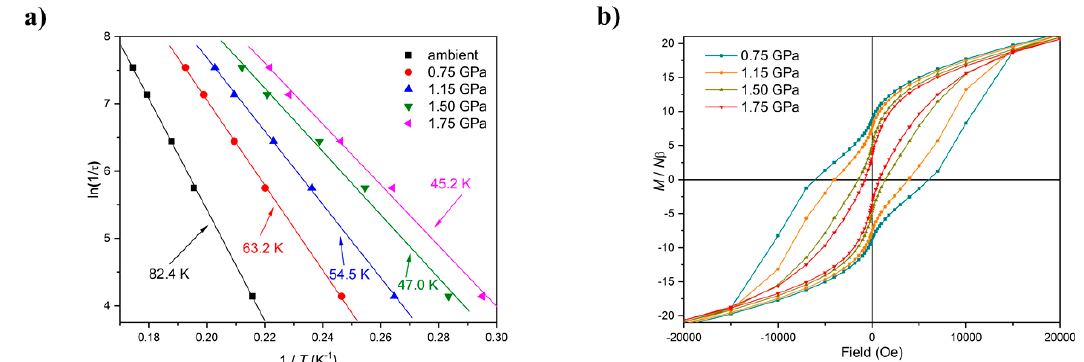
Figure 4. ( a ) Arrhenius plots based on out-of-phase ac susceptibility measurements of 1 at different pressures. ( b ) Hysteresis loops for 1 recorded at the indicated pressures at 2 K.